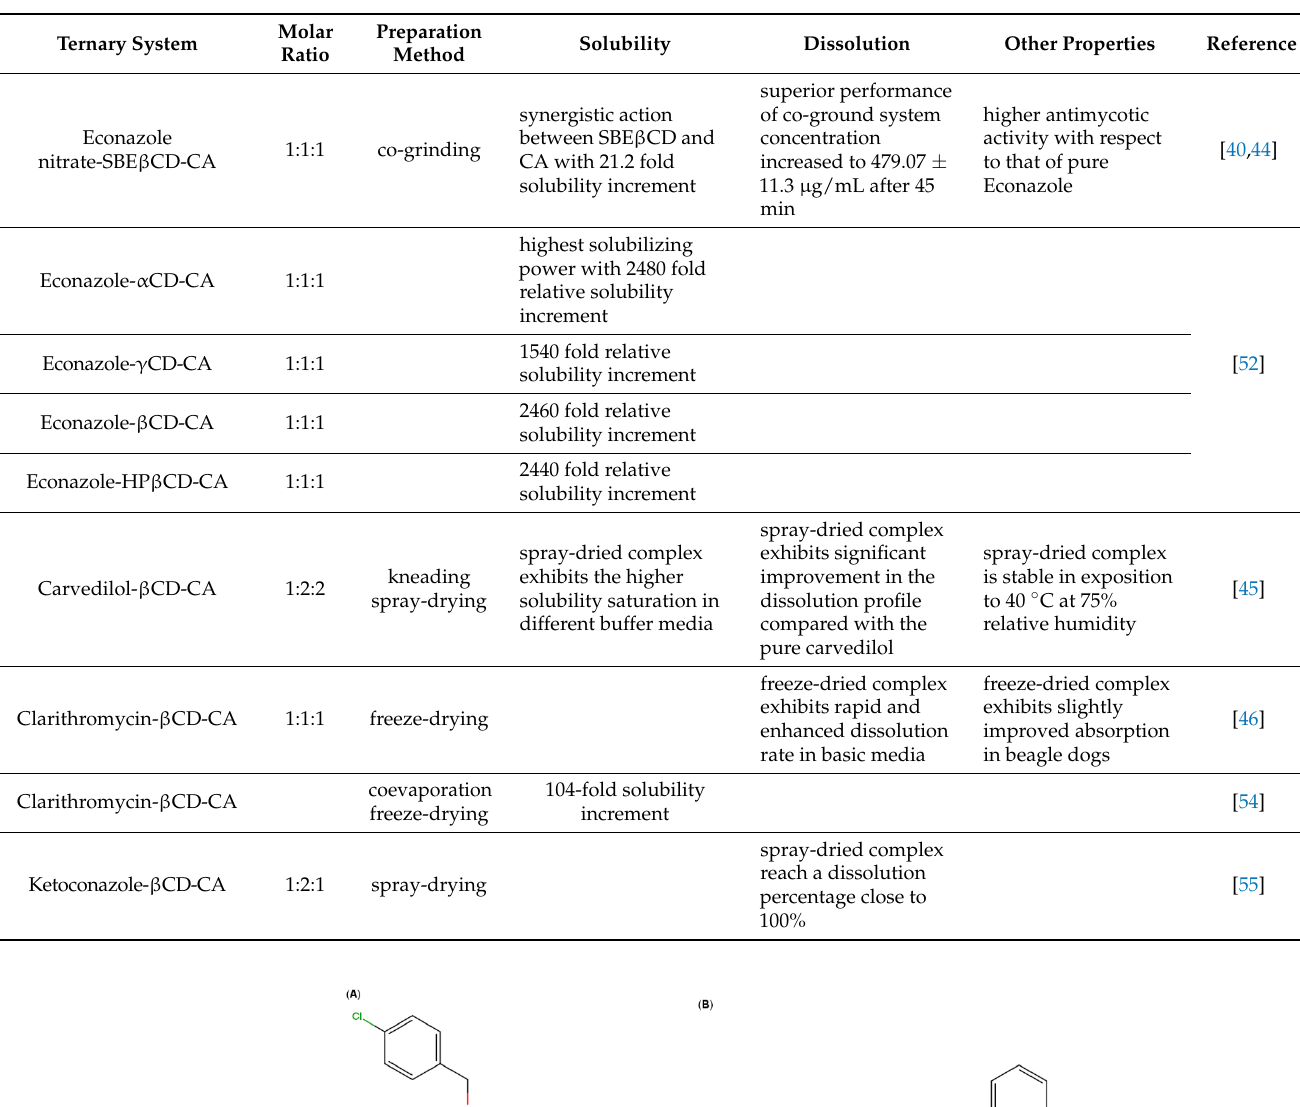
Table 2. A summary of some reports on ternary complexes of cyclodextrins with citric acid (CA), including the pharma- ceutical improvements. Ternary System